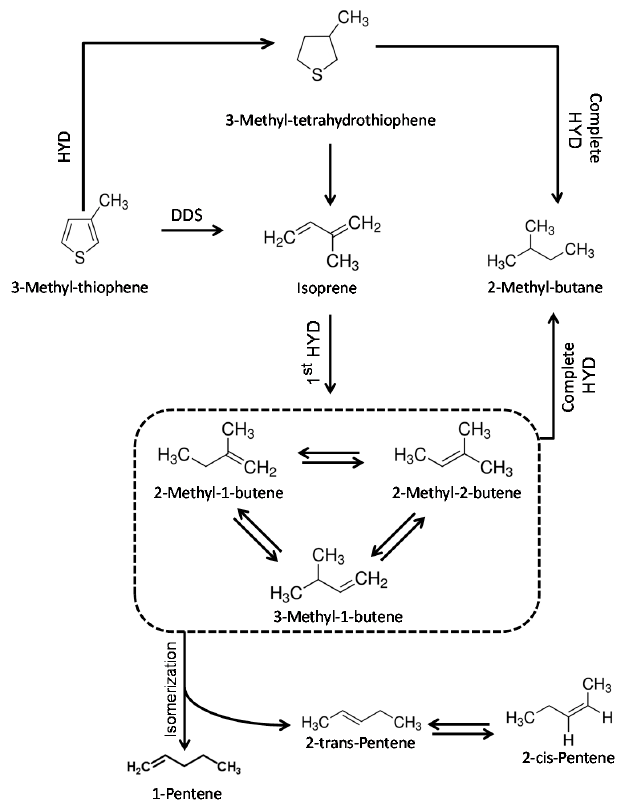
Figure 5. Reaction path network for the 3-methyl-thiophene hydrodesulfurization. DDS: desulfurization; HYD: hydrogenation.